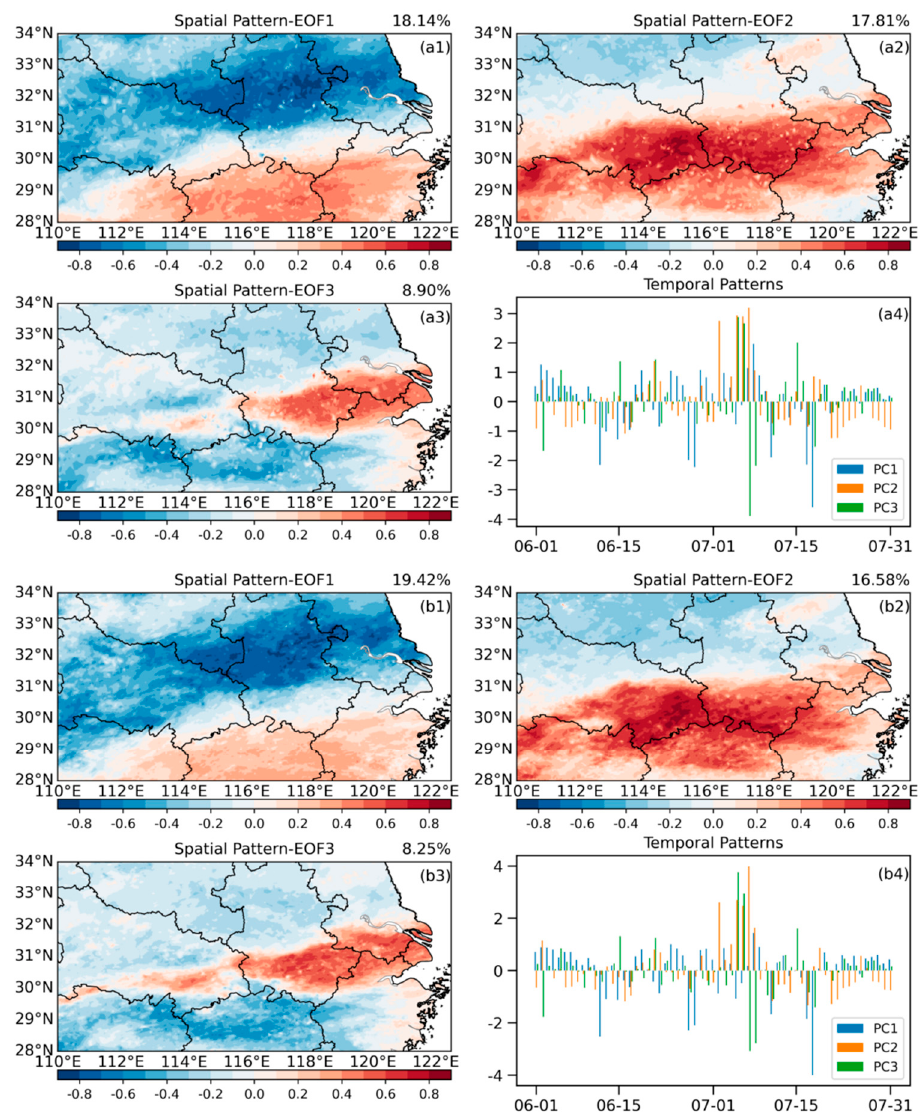
Figure 9. Analysis of empirical orthogonal function (EOF) modalities of daily precipitation between rain-gauge observations and CMPAS-NRT products in the Meiyu monitoring area during the 2020 Meiyu precipitation period, where ( a1 – a3 ) are the first, second, and third normalized spatial modes obtained from rain-gauge observations, respectively, the percentages (%) on the plots are the variance contributions of each mode, and ( a4 ) shows the time coefficients corresponding to each of their modes (blue line is the main river). Panels ( b1 – b4 ) are the results obtained by CMPAS.